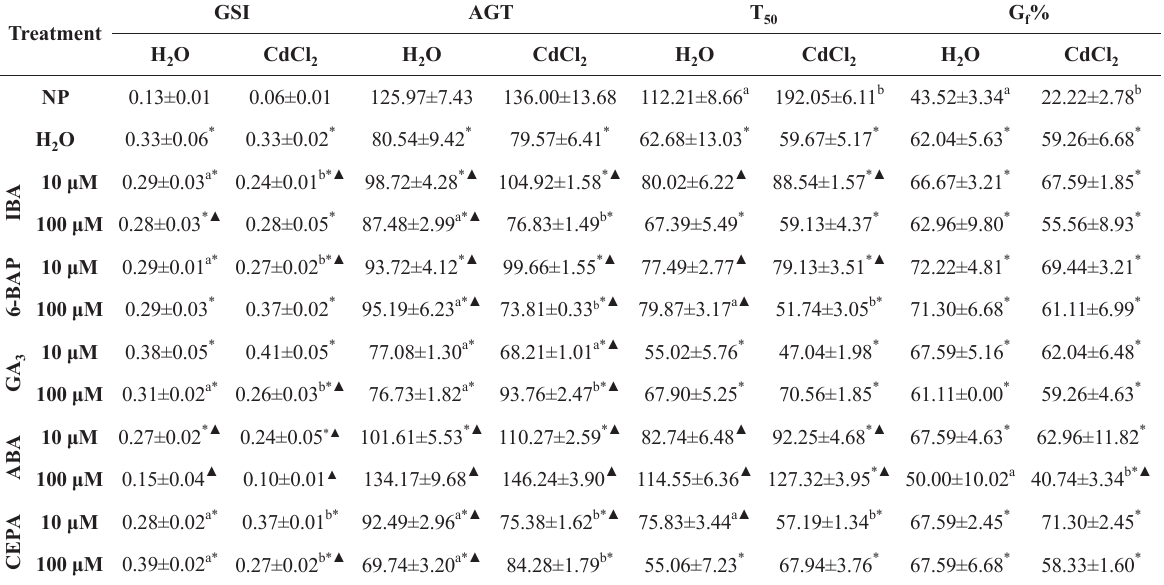
Means marked with asterisk in the columm indicate that hormonal priming or H O are different from NP, and means marked 2 with triangle indicates that hormonal priming is different from H O treatment. Different letters in the row indicate that there is 2 significant difference between H O and CdCl . These differences are obtained from Dunkan's test at P < 2 2